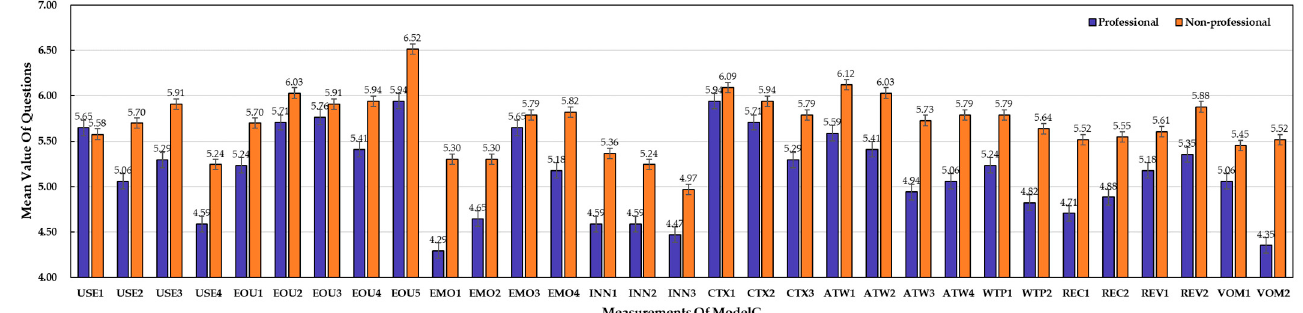
Figure 11. Comparison results of all measurements of Model C between professional and non-professional groups.